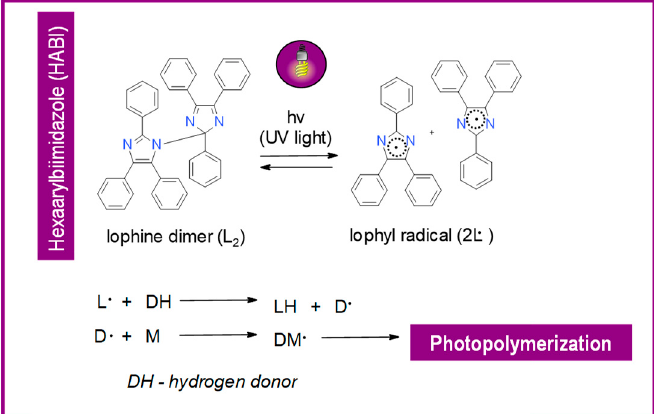
Figure 16. Proposed mechanism of the photolysis of the carbon-nitrogen (C–N) bond between the imidazole rings of HABI.